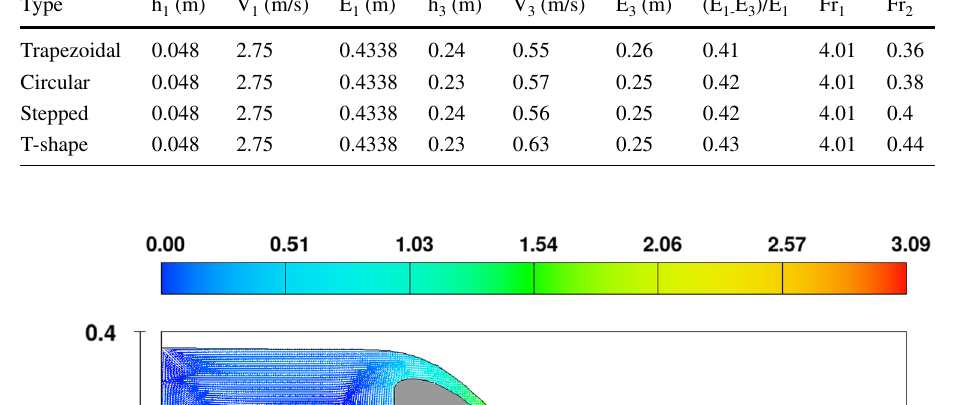
Table 3 The results of numerical modeling of the single-row energy-dissipating block